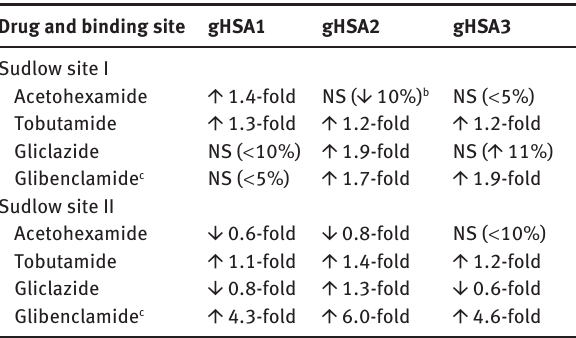
) for various sulfony- a